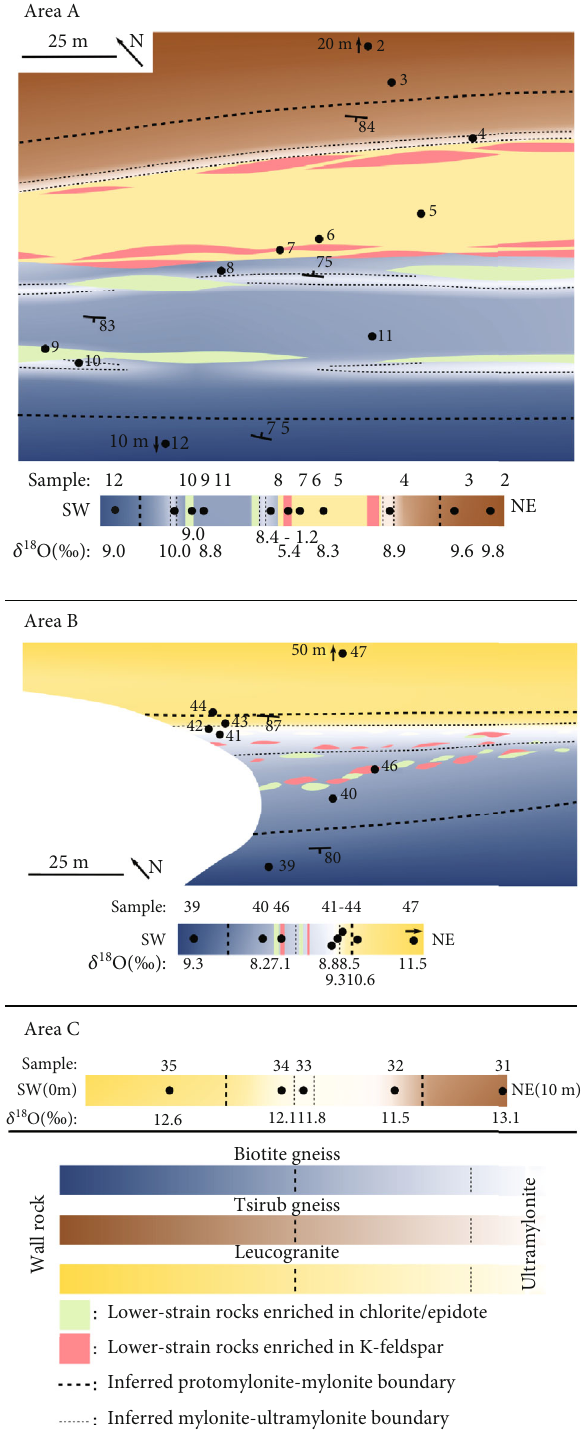
Figure 2: Maps of the studied areas (A-C) within the KMZ. Maps include locations of sampled rocks and their δ 18 O values. Rock descriptions and GPS locations can be found in Table S1.